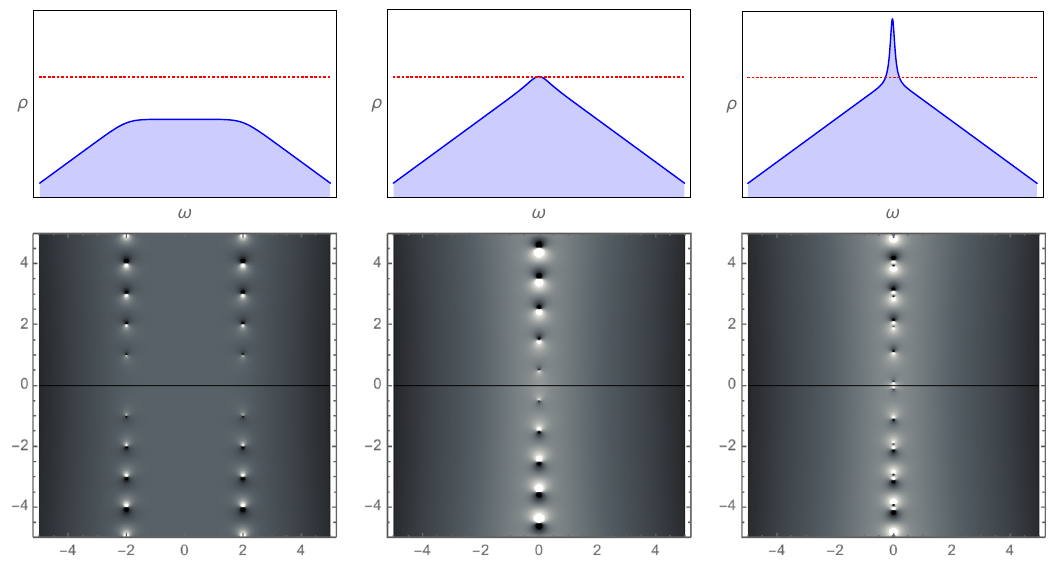
Figure 6 . Regularized scalar ρ ( ω ) , d = 2 , ν = 2 , i/ 2 , 0 . 9 i ; top: ω ∈ R ; bottom: ω ∈ C , showing quasinormal mode poles. See figures 10, 13 for